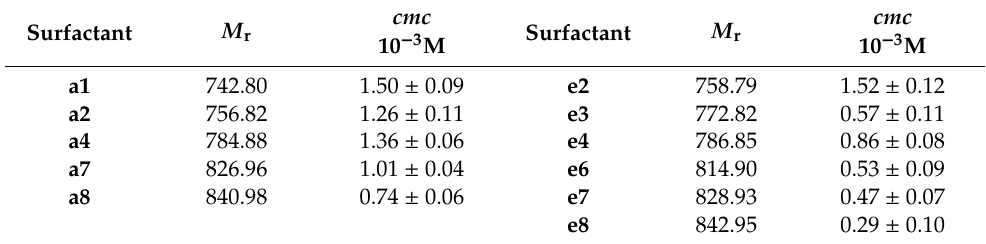
Figure 1. Micelle aggregation number N of plotted as a function of concentration c/cmc for spacer values s of diamide gemini surfactants a(s) . The solid curves are a guide to the eye. The fitting constant R from the fluorescence decay measurements and the aggregation number N of a(s) micelles calculated from Equation (2) in Section 3.2 are listed in Table 2 for all concentration values c / cmc and spacer values s .